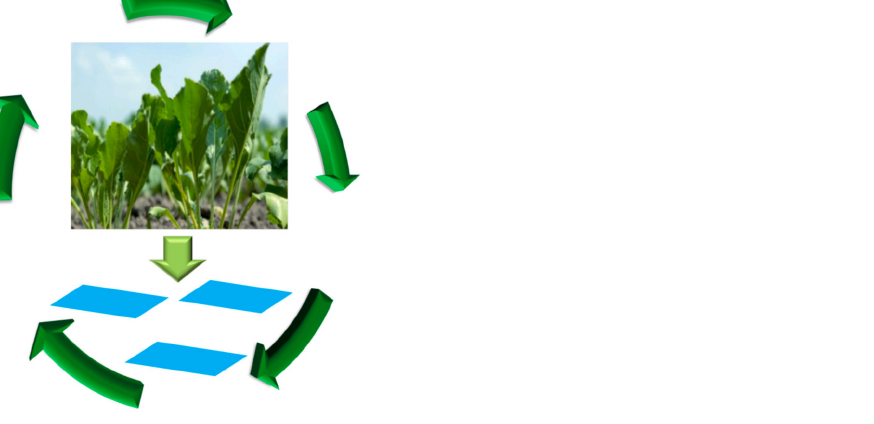
Figure 2. Schematic diagram representing the renewable circle of graphene sheets as new generation flame-retardant materials. Reproduced with permission [28]. Copyright 2021, Elsevier.